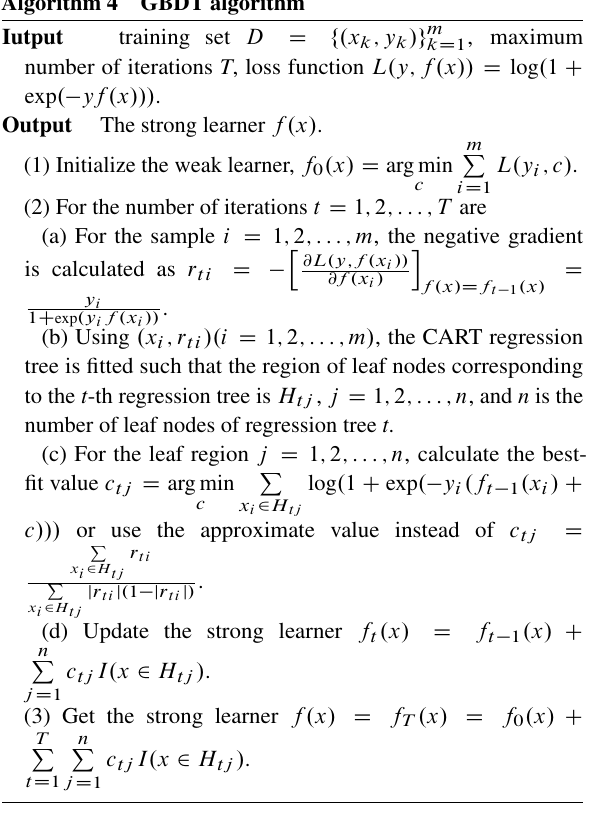
Algorithm 5 t-SNE dimensionality reduction